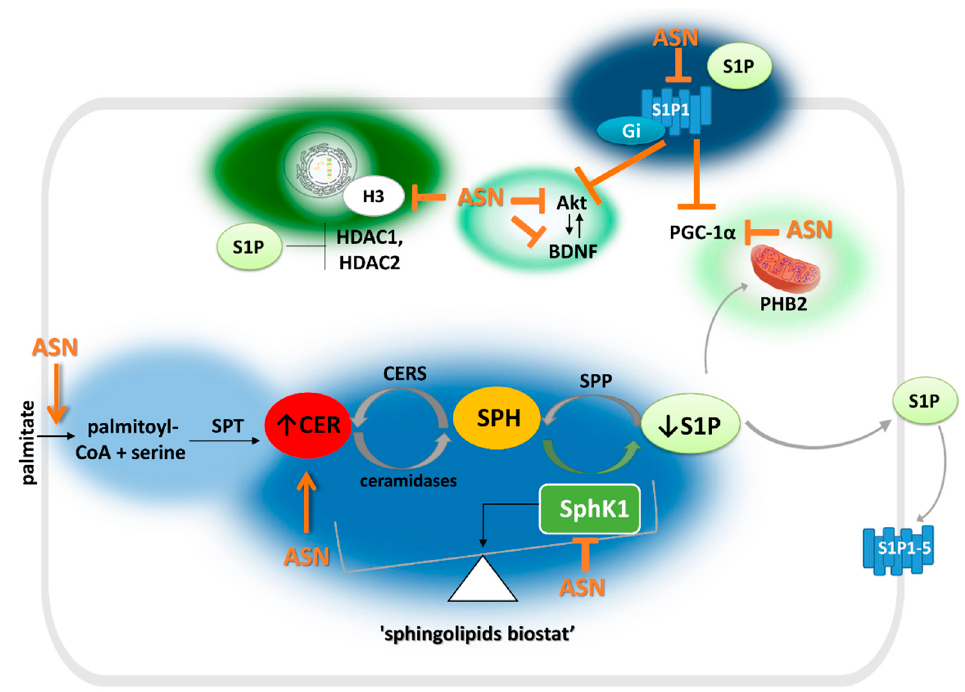
Figure 4. Potential targets for PD neuroprotective strategies associated with sphingolipid signaling Figure 3. ASN toxicity on S1P metabolism and action. Orange arrows terminating with → (activation), and anti-oxidative defense. Arrows terminating with → represent activation, while those terminat- Figure 3. ASN toxicity on S1P metabolism and action. Orange arrows terminating with → (activa- or ing with ┴ represent inhibition/deterioration. Abbreviations: PD-Parkinson’s disease; ASN—alpha- tion), or ┴ (inhibition/deterioration) mark alpha-synuclein (ASN) toxic effects. This includes pro- synuclein; Sirt1—silence information regulator 1 (sirtuin 1); OS—oxidative stress; CER—ceramide; motion in palmitate uptake [84], which may increase ceramide synthesis (bright blue), inhibition of S1P—sphingosine-1-phosphate; SPL—S1P lyase; Hex + Phe—hexadecenal and ethanolamine phos- kinase 1 (SphK1) [31,80,85] (regular blue), as well as expulsion of sphingosine-1-phosphate (S1P) sphingosine kinase 1 (SphK1) [31,80,85] (regular blue), as well as expulsion of sphingosine-1-phos- phate (S1P degradation products); S1P1—S1P receptor 1; Gi—inhibitory G protein; HDAC1, receptor (S1P1) from lipids rafts, and suppression of inhibitory G (Gi) protein [30,80] (navy blue). phate (S1P) receptor (S1P1) from lipids rafts, and suppression of inhibitory G (Gi) protein [30,80] HDAC2—histone deacetylases 1 and 2; PI3K/Akt—phosphatidylinositol 3-kinase/serine/threonine ASN acts in opposition with S1P in an intracellular and receptor-dependent effect on mitochondrial (navy blue). ASN acts in opposition with S1P in an intracellular and receptor-dependent effect on protein kinase B; ERK1/2—extracellular signal-regulated kinases; BDNF—brain-derived neu- homeostasis (bright green), including inhibition/up-regulation of peroxisome proliferator-activated mitochondrial homeostasis (bright green), including inhibition/up-regulation of peroxisome prolif- rotrophic factor; FTY720—fingolimod; BAF312—siponimod; SphKs—sphingosine kinases Note that receptor gamma-coactivator 1-alpha (PGC-1 α ) [76,86]. S1P may also regulate assembly of complex IV erator-activated receptor gamma-coactivator 1-alpha (PGC-1 α ) [76,86]. S1P may also regulate as- sphingosine kinases were abbreviated as Sphks. However, inhibition under OS conditions mainly of respiratory chain by interaction with mitochondrial protein prohibitin 2 (PHB2) [87]. Pathogenic sembly of complex IV of respiratory chain by interaction with mitochondrial protein prohibitin 2 affects the Sphk1 isoform synthesizing the S1P pool acting through S1P receptors [9], while Sphk2 ASN and S1P inhibit and activate, respectively, the Akt kinase (serine/threonine protein kinase (PHB2) [87]. Pathogenic ASN and S1P inhibit and activate, respectively, the Akt kinase (serine/thre- synthesizes S1P-inhibiting HDACs. The dashed line connecting S1P ( ↓ S1P) with HDAC1, HDAC2 onine protein kinase B)/brain-derived neurotrophic factor (BDNF) signaling pathway [81,83,88,89] B)/brain-derived neurotrophic factor (BDNF) signaling pathway [81,83,88,89] (regular green). S1P determines that S1P is an endogenous inhibitor of HDACs, and its decline partially abolishes (regular green). S1P inhibits histone deacetylase 1 and 2 (HDAC1 and HDAC2), thus enhancing inhibits histone deacetylase 1 and 2 (HDAC1 and HDAC2), thus enhancing histone acetylation [90], HDACs inhibition while leading to increased histone deacetylation [90]. histone acetylation [90], while ASN hinders access of histone acetyltransferases (HATs) by interact- while ASN hinders access of histone acetyltransferases (HATs) by interacting with histone H3 [28] ing with histone H3 [28] (dark green). Remaining abbreviations: CoA—coenzyme A; SPT—serine (dark green). Remaining abbreviations: CoA—coenzyme A; SPT—serine palmitoyl transferase; palmitoyl transferase; CER—ceramide; SPH—sphingosine; CERS—ceramide synthase; SPP—S1P CER—ceramide; SPH—sphingosine; CERS—ceramide synthase; SPP—S1P phosphatase; S1P1–5— phosphatase; S1P1–5—sphingosine-1-phosphate receptors. Please note that sphingosine kinase was sphingosine-1-phosphate receptors. Please note that sphingosine kinase was abbreviated Sphk1, abbreviated Sphk1, which is an isoform down-regulated by ASN. However, S1P acting intracellu- which is an isoform down-regulated by ASN. However, S1P acting intracellularly on PHB2 and larly on PHB2 and HDACs is synthesized by Sphk2 isoform [90]. HDACs is synthesized by Sphk2 isoform